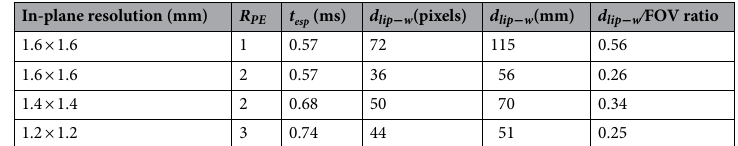
In-plane resolution